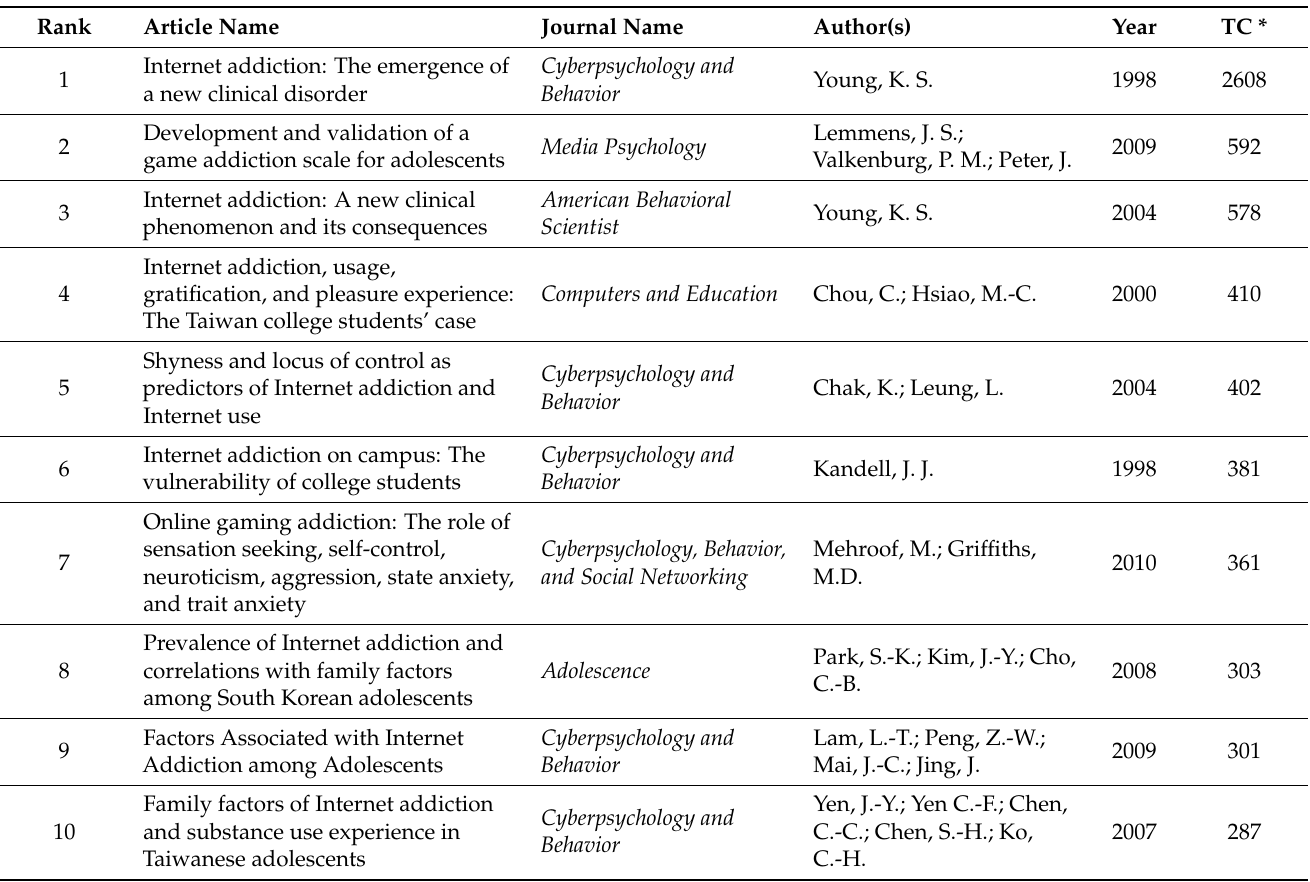
Table 4. Top 10 articles cited in digital addiction.